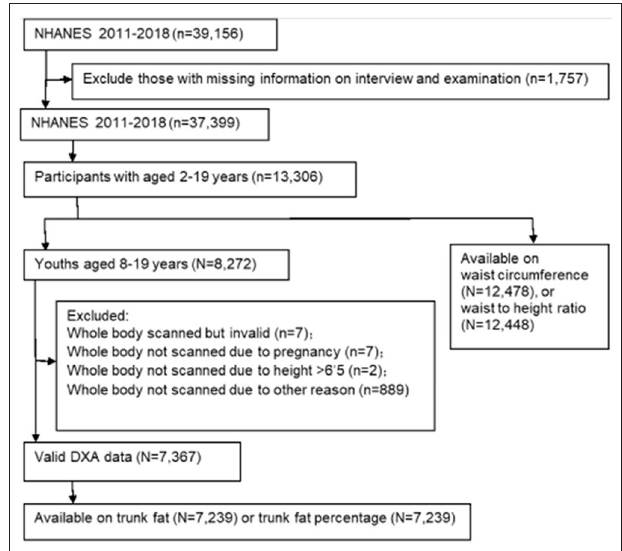
FIGURE 1 | Flow chart of participants selected from NHANES 2011–2012 to 2017–2018.